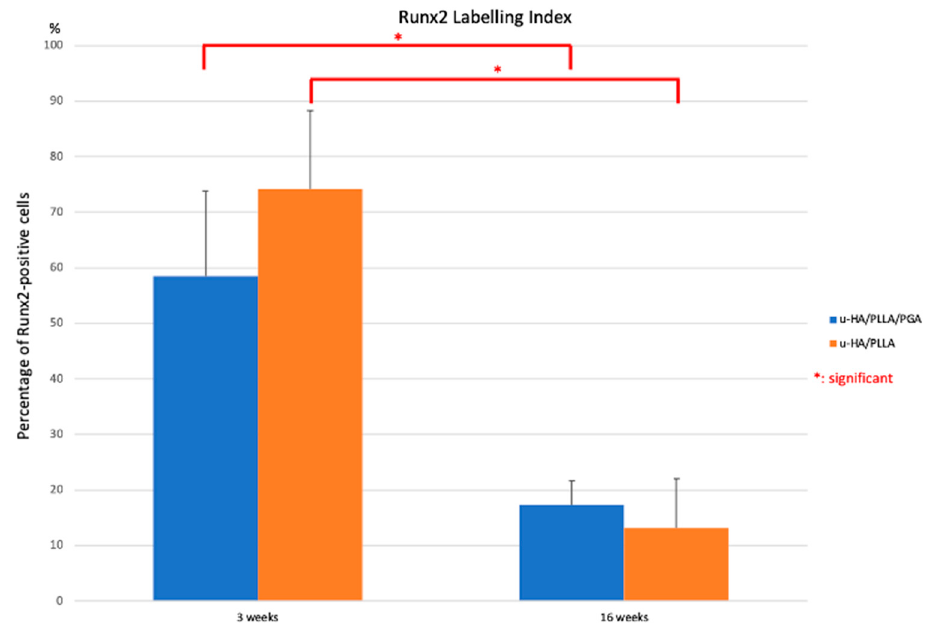
Figure 9. Runx2 labeling index in the u-HA/PLLA/PGA and u-HA/PLLA subgroups. * p <